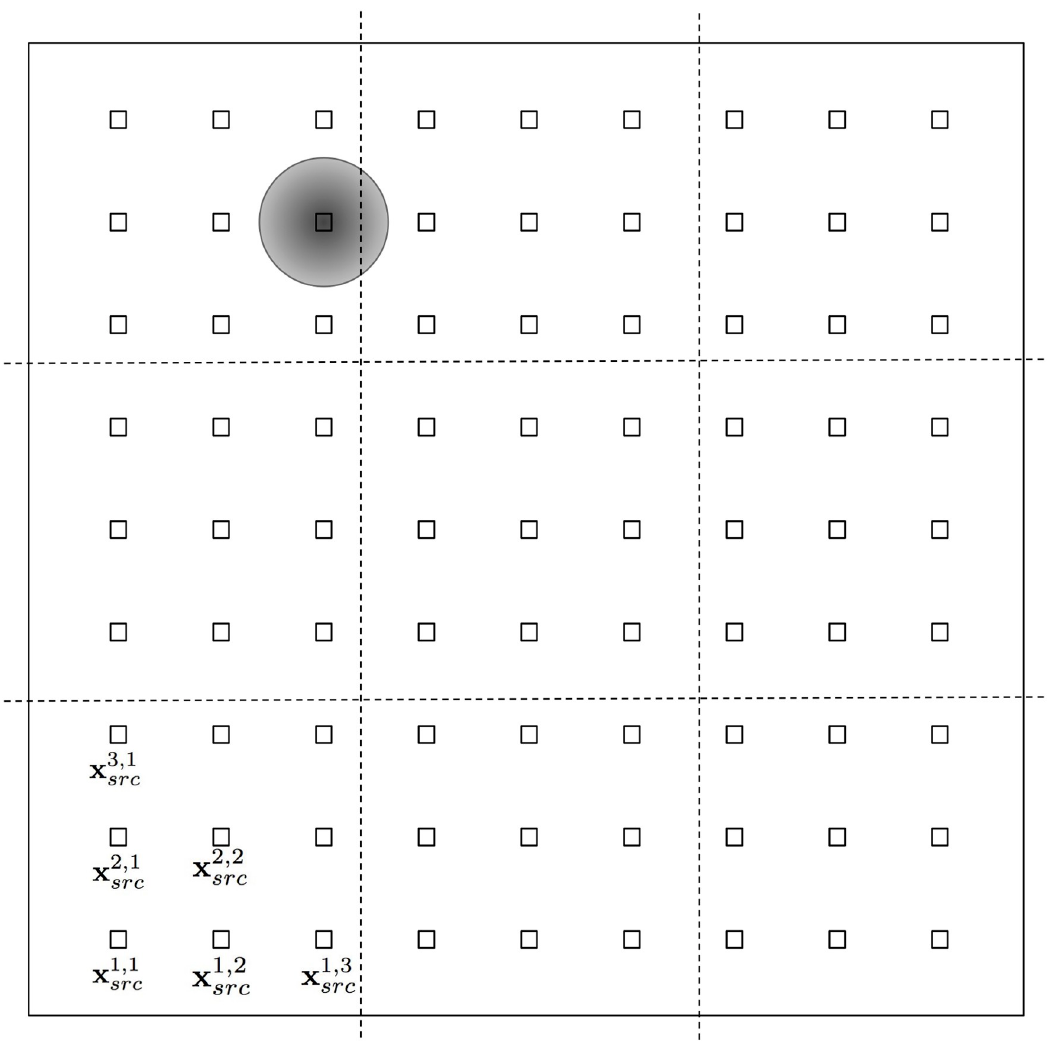
Fig 1. Numerical domain A = [ − 1, 1] × [ − 1, 1] and the position of the outbreak sources with coordinates x i ; j squares. For the sake of illustration we only label a few of them in the bottom-left corner. The shaded circle indicates the location of the outbreak location for the fluctuation case centered at x 3 ; 8